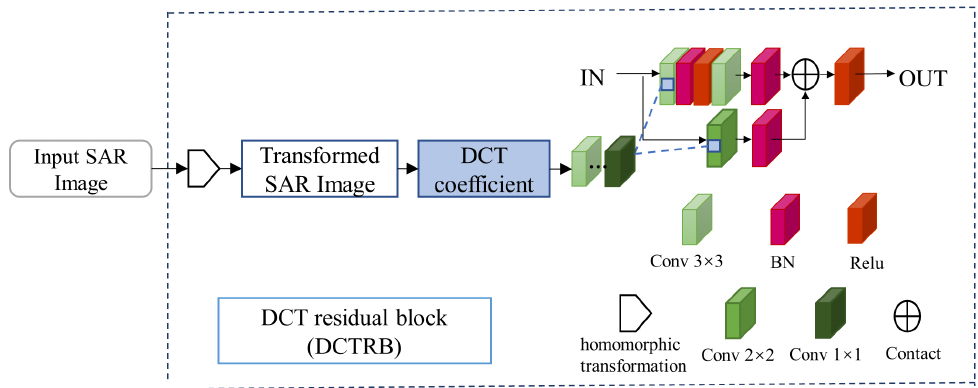
Figure 3. The architecture of DCTRB. DCT coefficient is a 256 × 256 size matrix, conv 3 × 3, conv 2 × 2 and conv 1 × 1 are the convolution operations of different convolution kernel sizes. The blue dotted line represents the concatenation on the feature channel of the DCT coefficient feature map and the SAR image feature map. BN represents batch normalization, Relu represents an activation function, and Contact represents addition operation. Best viewed in